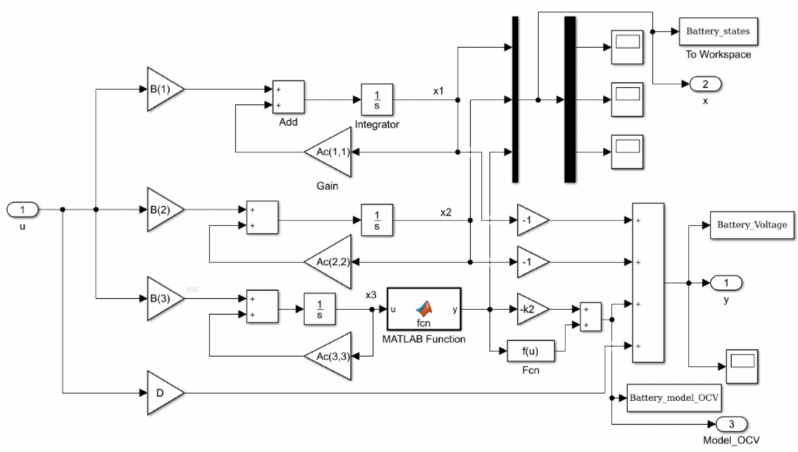
Figure 28. The Simulink model of the measurements’ generator block.